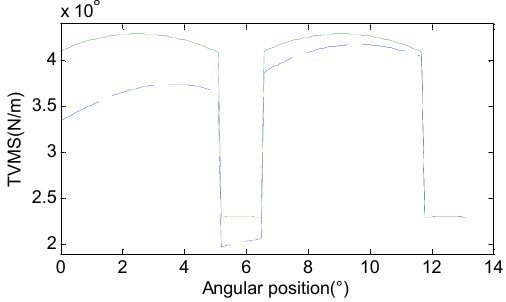
Figure 4. Meshing stiffness by the universal equation of a gear profile.